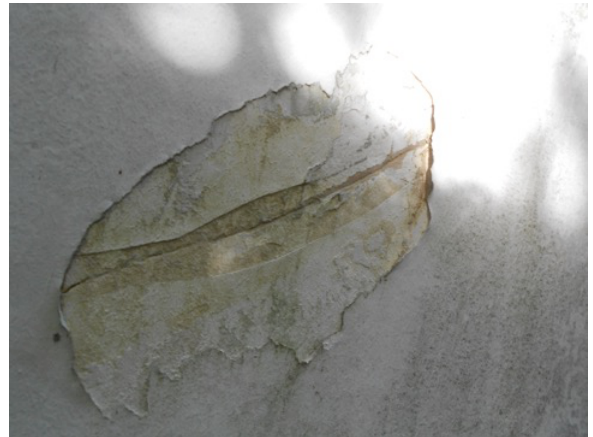
Figure 7. External surfaces decay, Eastern prospect, current state [Di Resta, 2015]